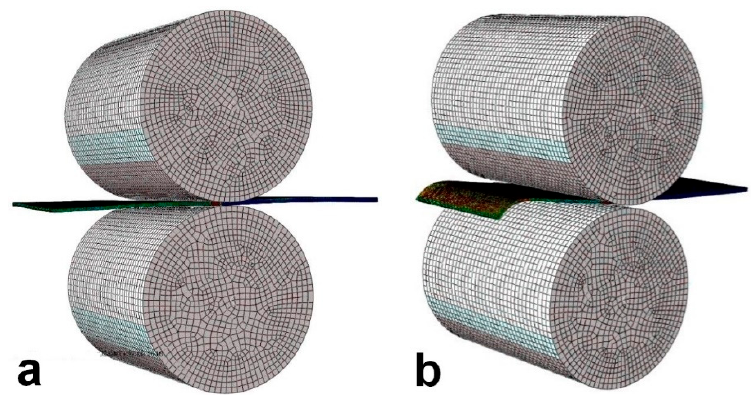
Figure 1. Numerical simulation of symmetric rolling ( a ) and asymmetric rolling ( b ).